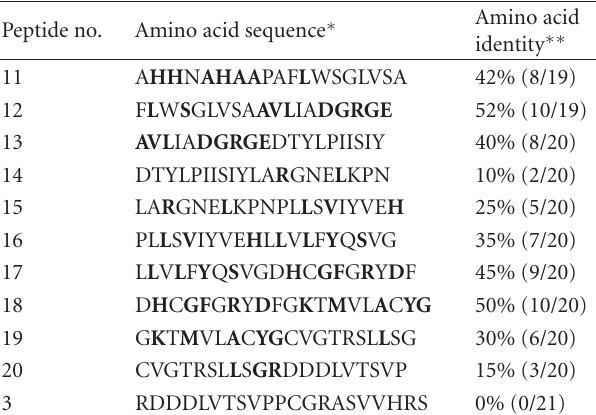
Table 1: ML1601c synthetic peptides. Peptide